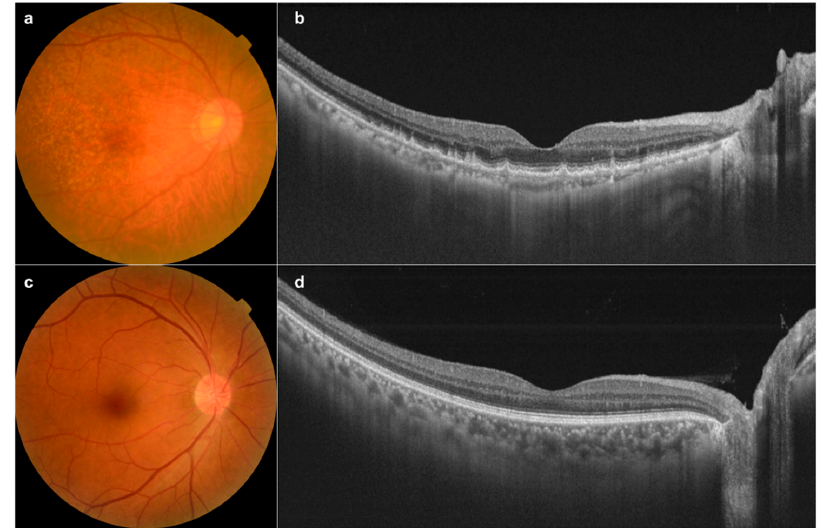
Figure 3. Fundus photography and optical coherence tomography of dry age-related macular degeneration (dAMD) and control retinas. ( a ) Numerous soft, yellow drusen in the right eye of a 78-year-old woman; ( b ) The corresponding OCT image shows multiple deposits accumulating under the retinal pigment epithelium. ( c ) Normal control fundus photography in the right eye of a 66-year-old man. ( d ) The corresponding OCT image of the control.